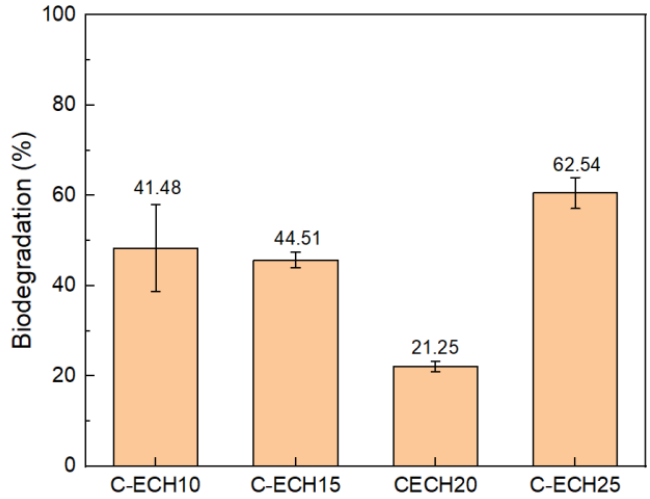
Figure 9. Percentage of biodegradation of the cellulose bioplastic samples at various ECH concen- trations.